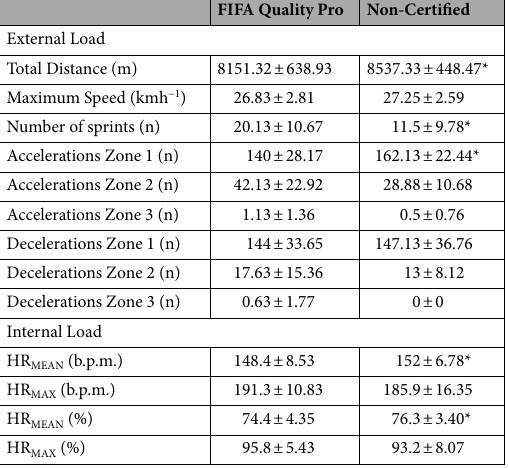
Table 3. External and internal load of BEAST 90 in a FIFA Quality Pro and non-certified artificial turf football fields. HR: Heart Rate *Significant differences between FIFA Quality Pro and non-certified fields ( p <